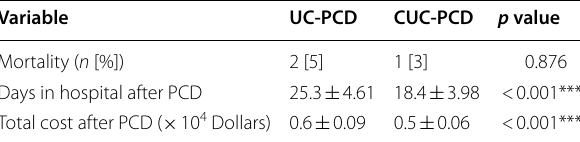
Table 5 Treatment information between the two groups